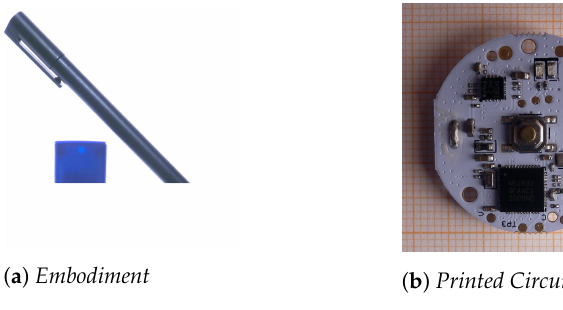
Figure 7. Small-Device prototype.